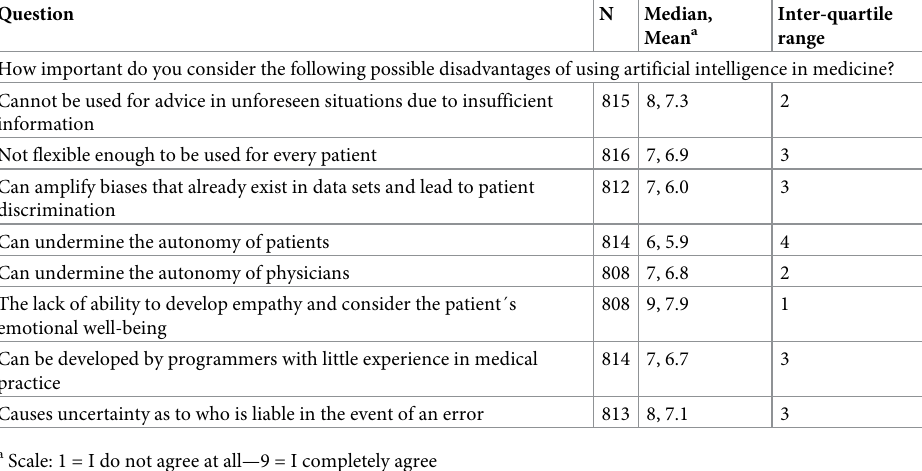
Table 4. Disadvantages of AI in